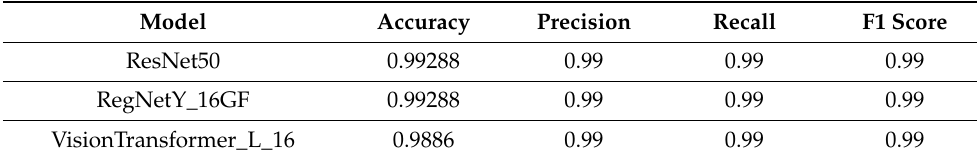
Table 6. Results for various models on DS-2 with CLAHE preprocess.